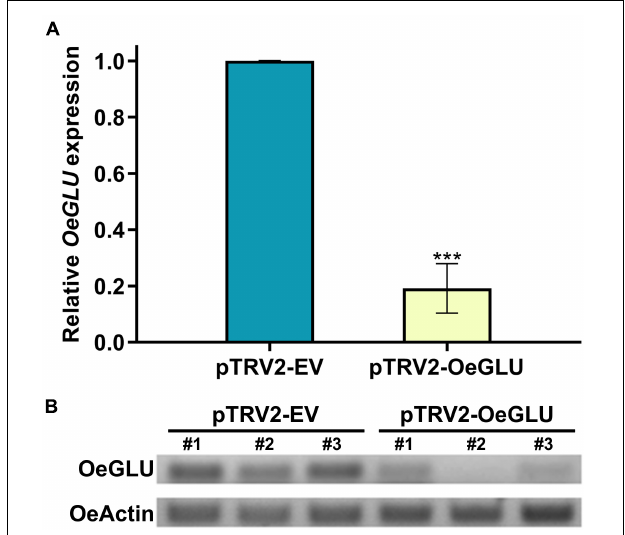
FIGURE 2 | VIGS-mediated silencing of OeGLU in olive plants. Real Time quantitative PCR (RT-PCR) (A) and semi-quantitative RT-PCR (B) analysis of OeGLU expression level of plants Agroinoculated with either pTRV2-EV or pTRV2-OeGLU constructs. OeActin was used as an internal control to normalize the samples. Three technical replicates of three biological replicates per treatment (A) or three biological replicates per treatment (B) were analyzed. Mean ± SE and asterisks denote statistical significance (*** P ≤ 0.001; Student’s t -test). Numbers indicate biological replicates. EV, empty vector; OeGLU, oleuropein β